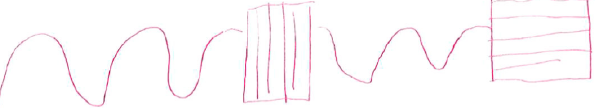
FIG. 8. Student S12_E drew how he imagined that the polarization of light was happening. The parallel lines are “ slits ” through which the transverse wave can or cannot pass.